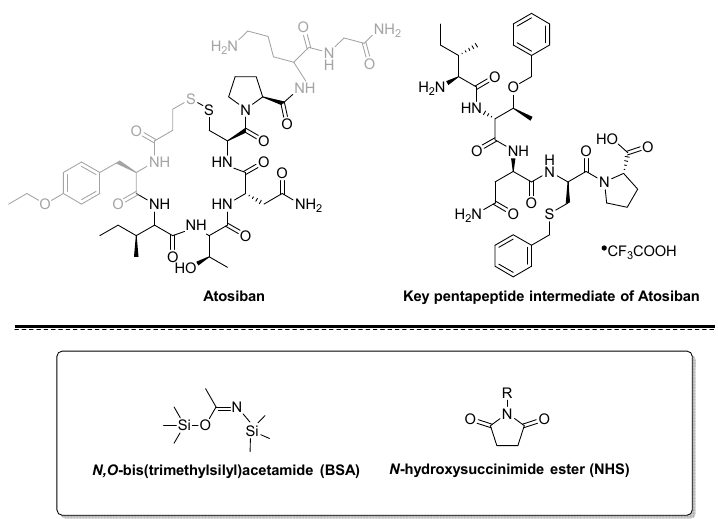
Figure 1. Structure of Atosiban, pentapeptide intermediate, BSA and NHS ester.